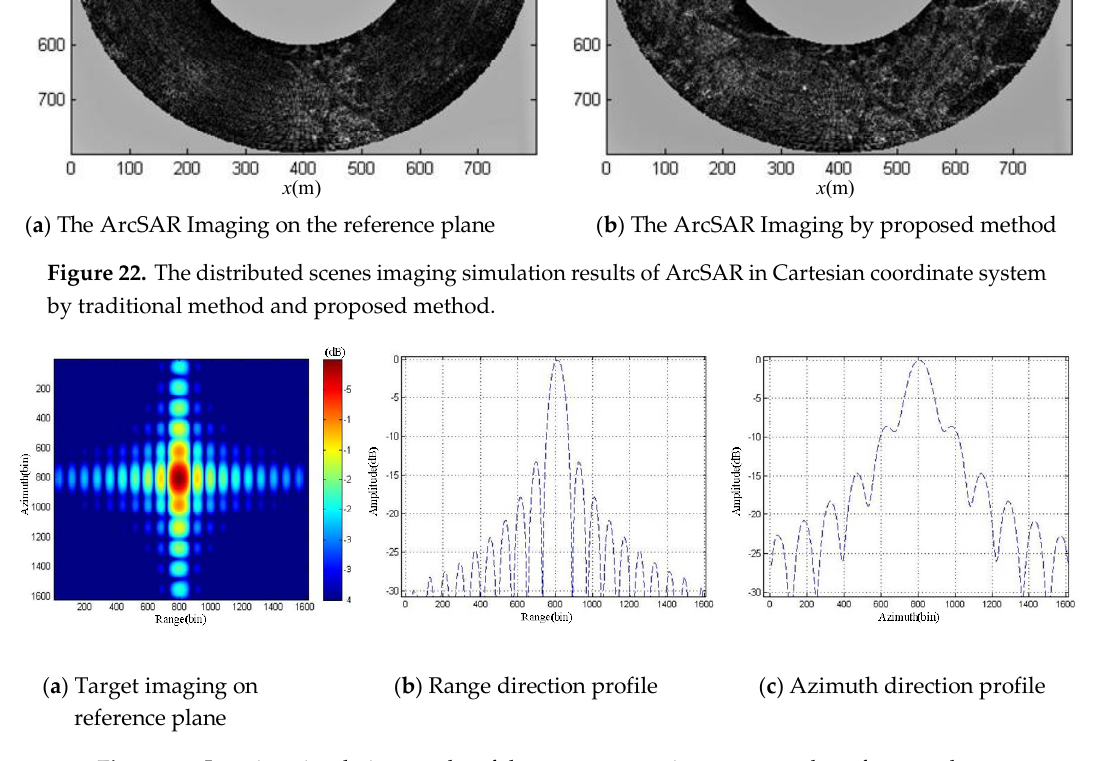
Figure 23. Imaging simulation results of the strong scattering target on the reference plane.